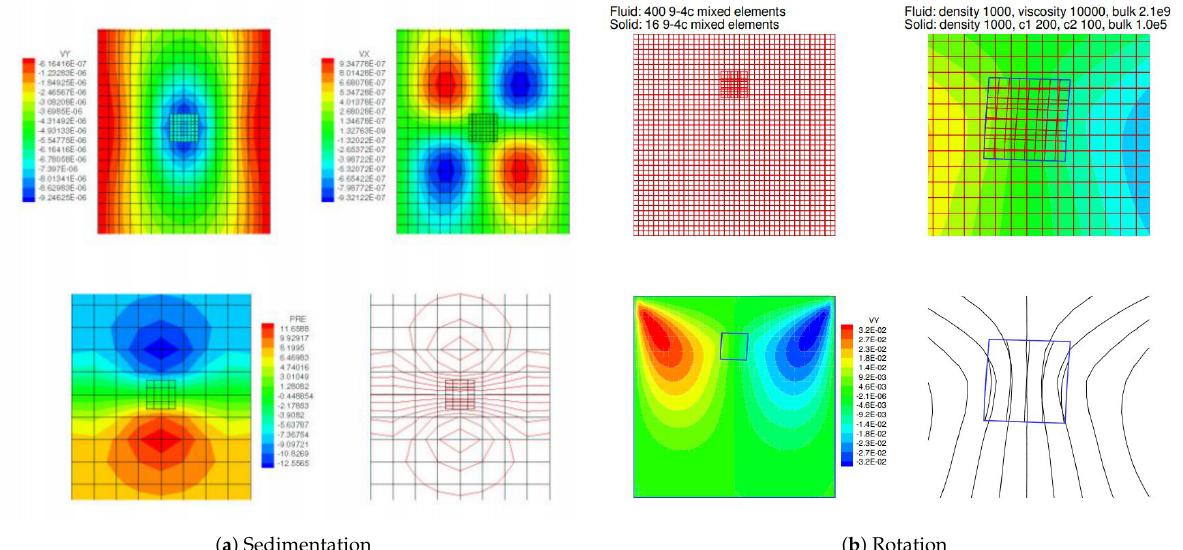
Figure 12. Simultaneous convergence of the monolithic implicit immersed method with matrix-free Newton– Krylov iteration.